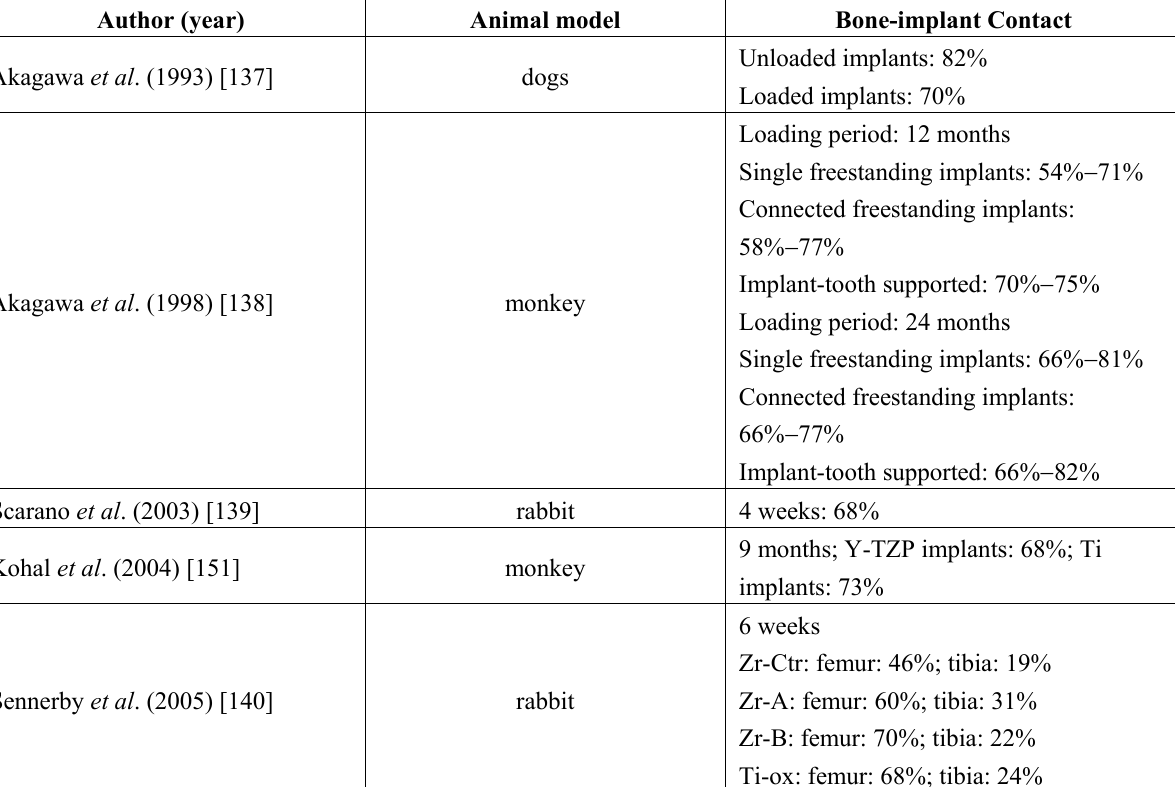
Table 1. Animal studies reporting on bone-to-implant contact for zirconia